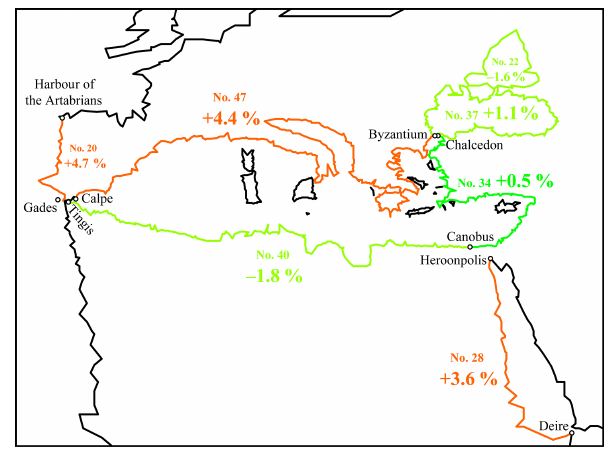
Figure 5. Differences between the coastline lengths in (cid:52) and in (cid:127) as expressed in terms of percentage of the (cid:52) values (for the same coastal stretches as shown on Fig.